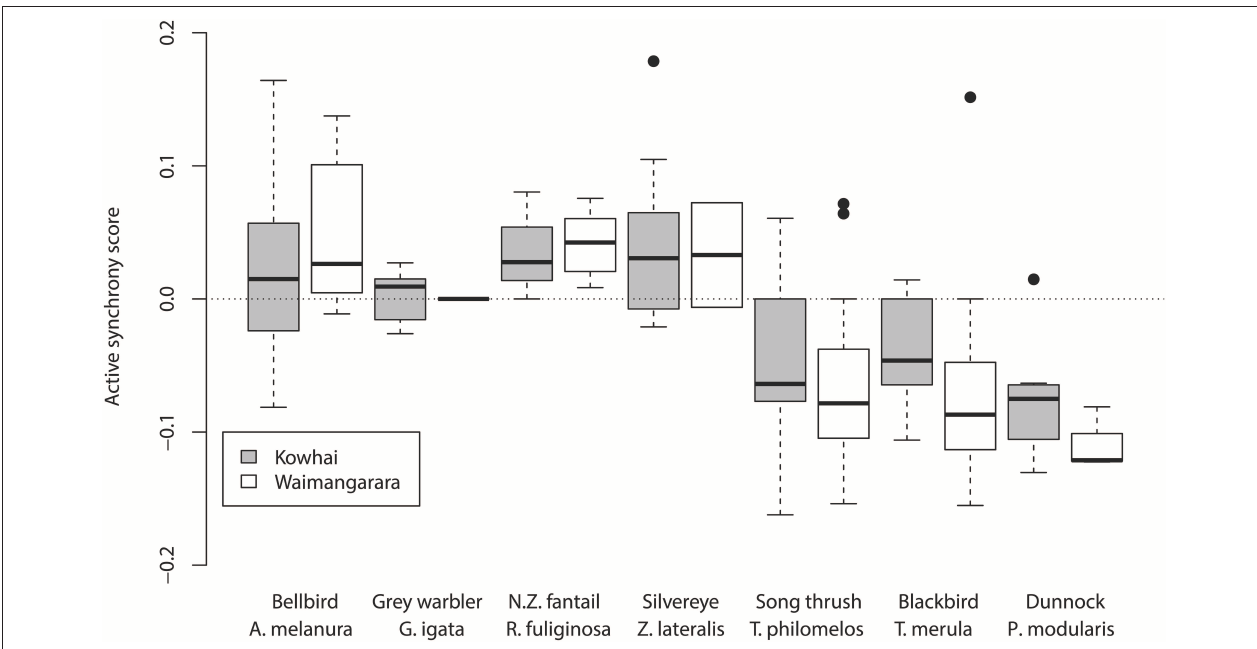
FIGURE 2 | A comparison of active synchrony scores between nest watches at Waimangarara Bush, from which predatory mammals were removed during the study period, and Kowhai Bush, from which they were not, for species recorded at both. Scores are observed proportions of visits that occurred within 120s of the previous, minus the median (“expected”) proportion from 100 simulated nest watches with the same visit rate. Full species scientific names are provided in Table 1 and Figure 1 .